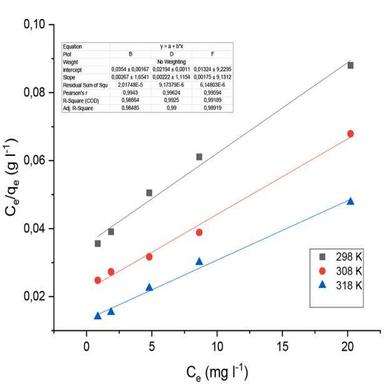
The plot of the Langmuir isotherm model.